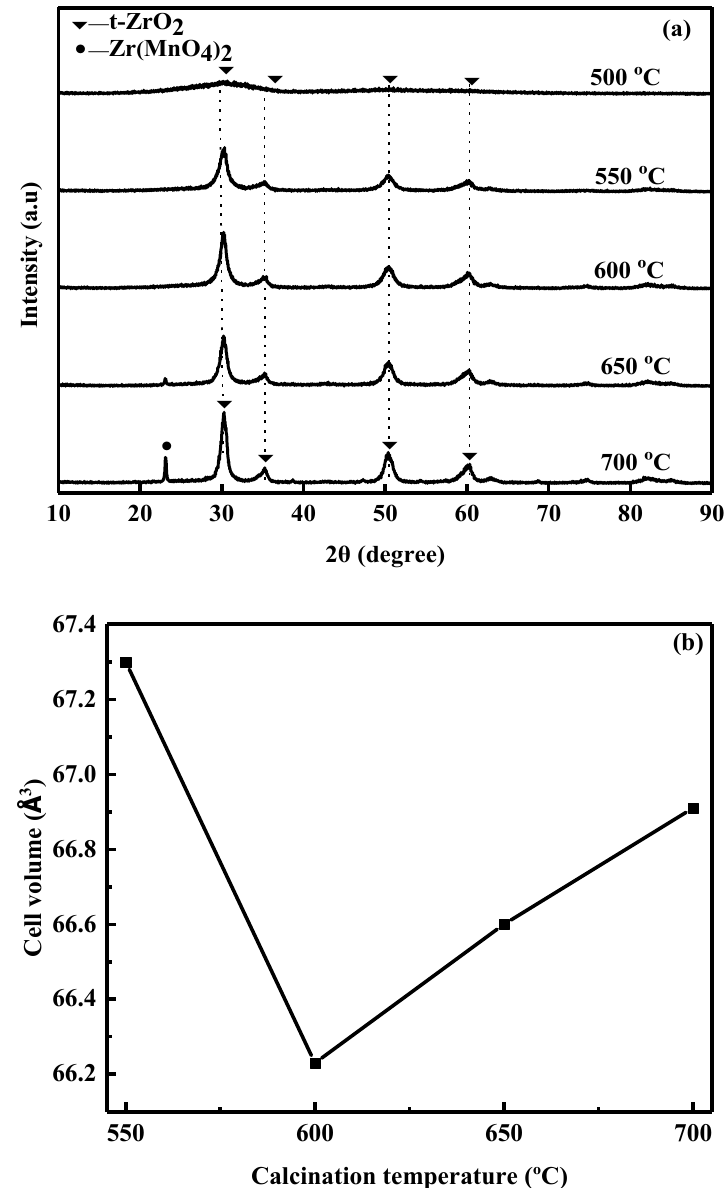
Figure 1. ( a ) XRD patterns of MoZr catalyst different calcination temperatures. ( b ) Lattice parameters of MoZr catalysts: 550 °C: a = b = 3.59 Å , c = 5.22 Å ; 600 °C: a = b = 3.59 Å , c = 5.13 Å ; 650 °C: a = b = 3.60 Å , c = 5.14 Å ; 700 °C: a = b = 3.59 Å , c = 5.20 Å .